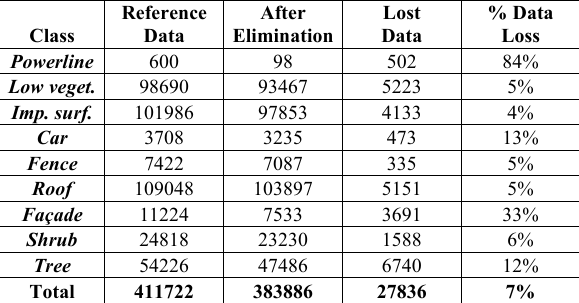
Table 4. Eliminated points during feature extraction, due to low point density